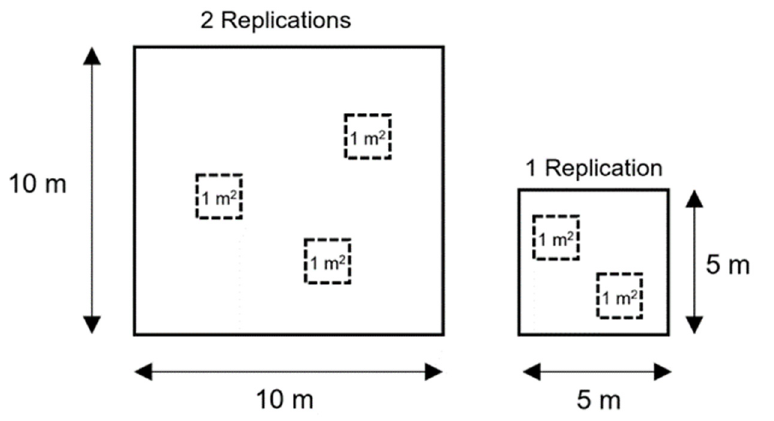
Figure A1. Salicornia experimental plots 10m x 10m (a) and 5m x 5m (b) at ICBA’s research station in the UAE.